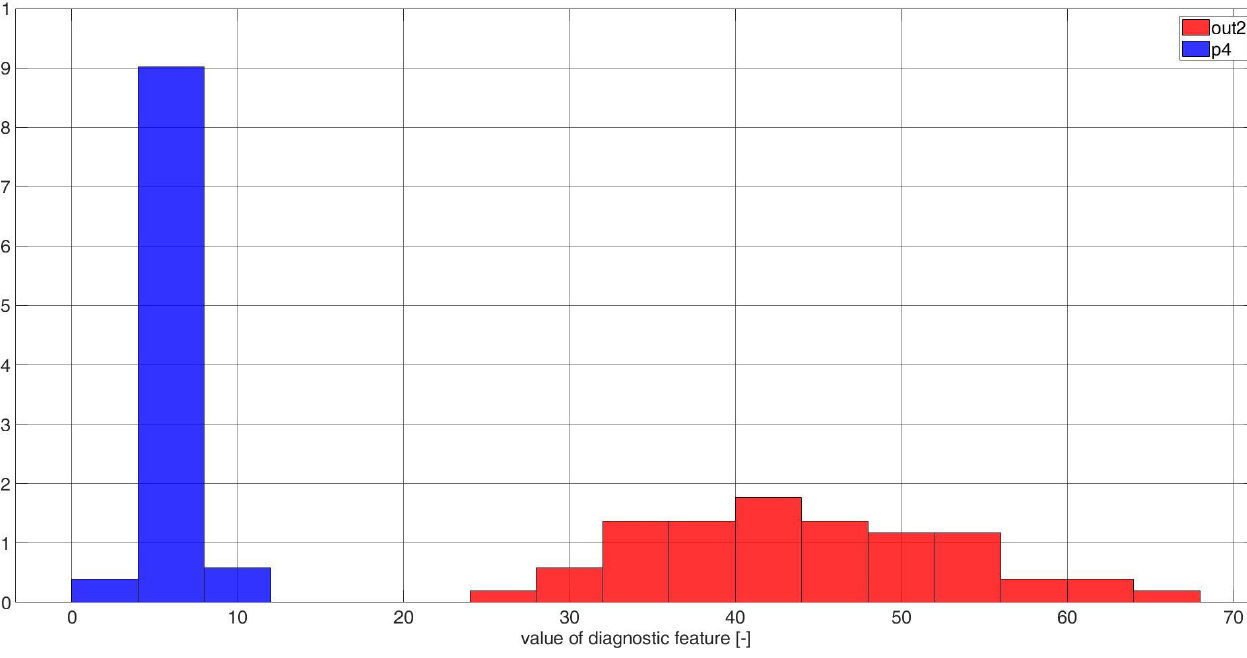
Figure A31. Histograms of diagnostic features based on the CCSM3 (correlation number is 3 — Table A2) bearings out2 and p4.